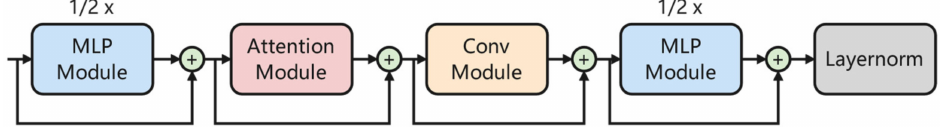
Figure 7. Convolution–Transformer module in the Local Branch.